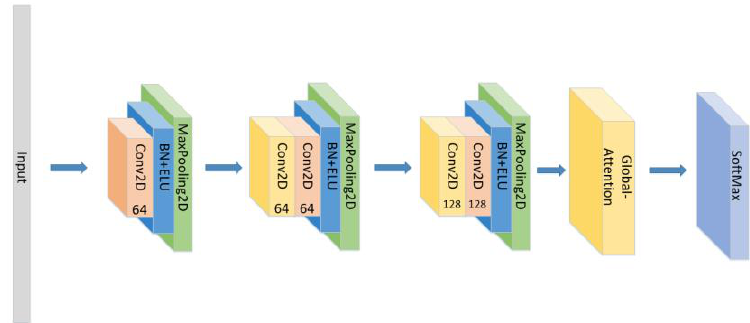
Figure 11. The construction of the CNN+Global-Attention model.